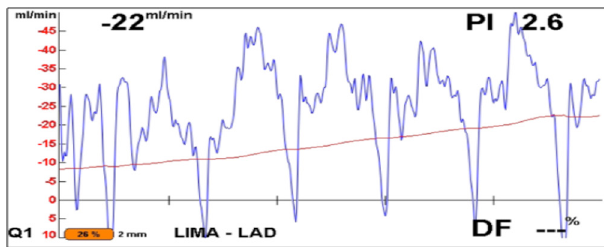
Fig. 2 – Flowmetry of the LIMA-LAD graft at the end of the surgical